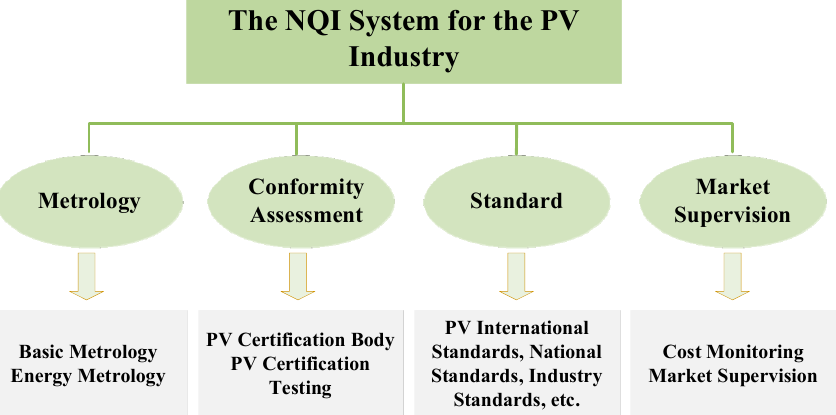
Figure 3. Establish an NQI system for photovoltaic industry.